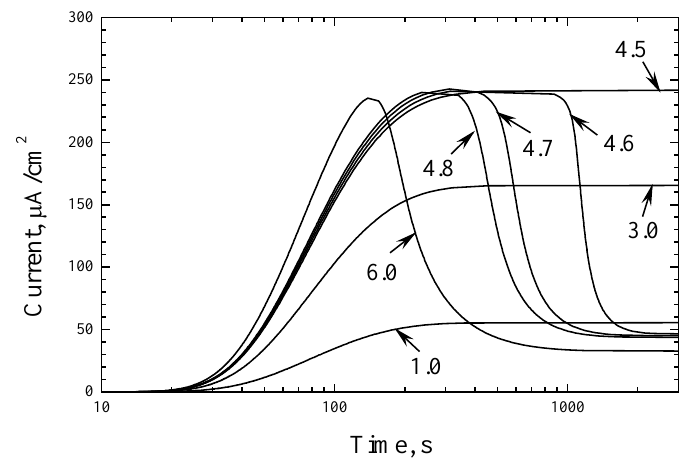
Figure 3 . Kinetics of biosensor response at different values of the normalised substrate concentration. Numbers on the curves show S